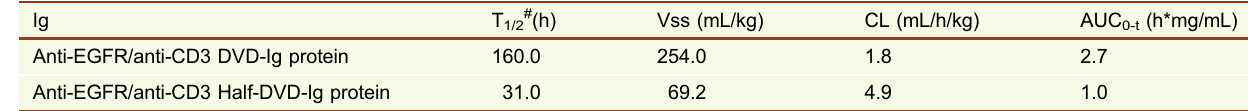
Table 1. Pharmacokinetic pro fi le of Half DVD-Ig compared to DVD-Ig molecules in Sprague Dawley rats Ig T 1/2# (h) Vss (mL/kg) CL (mL/h/kg) AUC 0-t (h*mg/mL) Anti-EGFR/anti-CD3 DVD-Ig protein